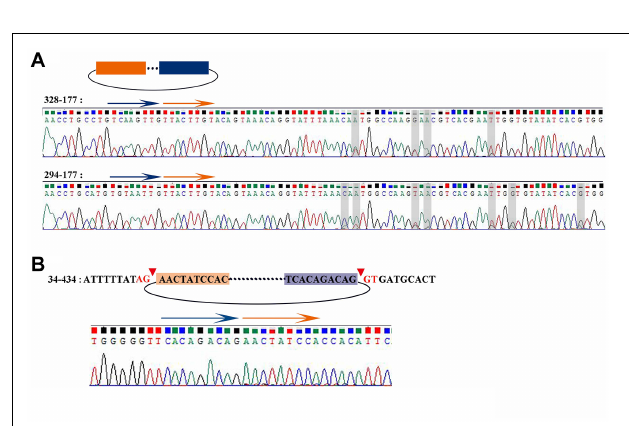
FIGURE 5 | Sanger sequencing result of 328-177, 294-177, and 34-434. (A) Sanger sequencing of 328-177 and 294-177 confirmed the back-splicing junction in PCR products. Some overlapping peaks might mean that more than two transcripts formed by alternative splicing. (B) Sanger sequencing of 34-434 confirmed the back-splicing junction in PCR